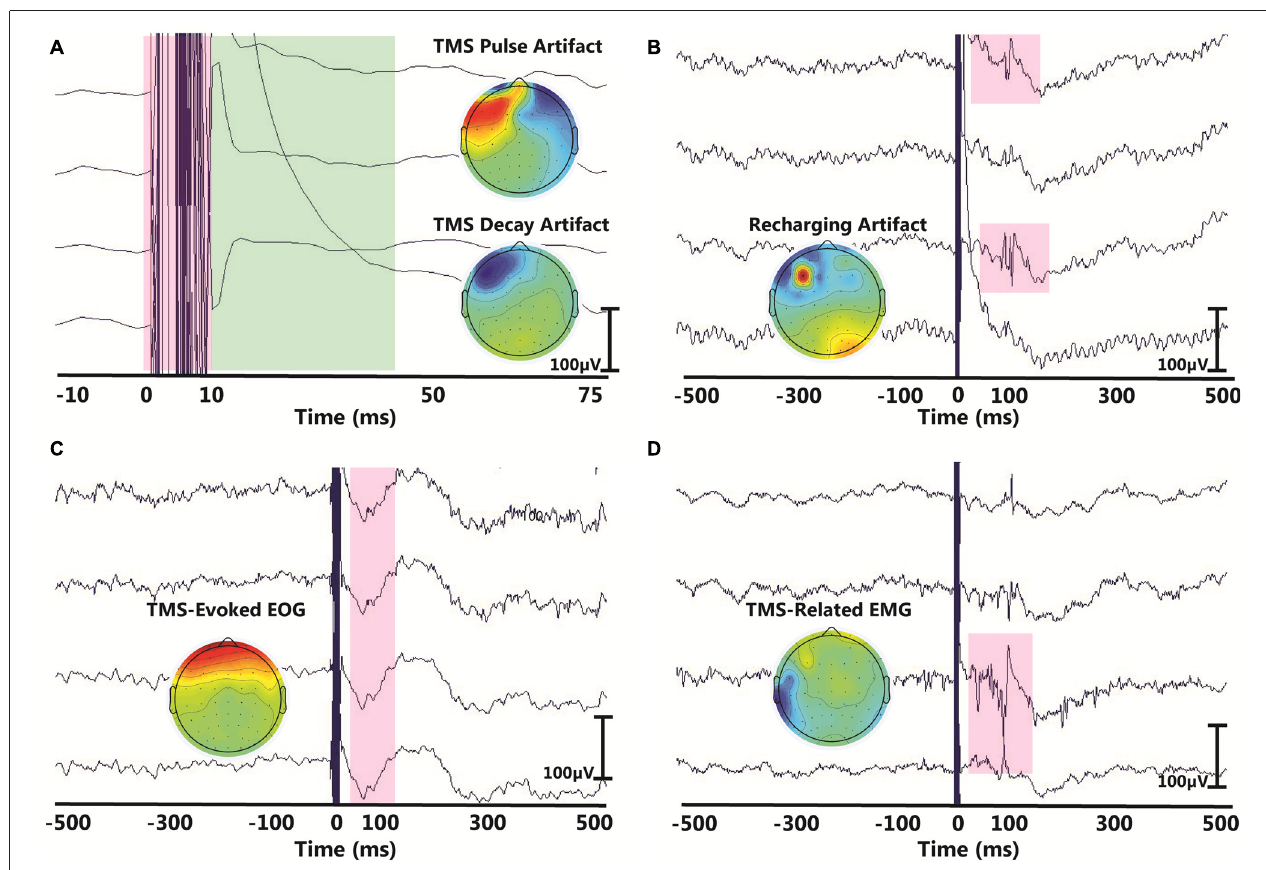
FIGURE 1 | Examples of common artifacts in transcranial magnetic stimulation-electroencephalography (TMS-EEG) data. In each panel, the x -axis represents time in the millisecond range and y -axis represents the amplitude of the EEG signal in the microvolt range. Topographical maps in each panel illustrate the scalp projection of each corresponding artifact. The displayed artifacts are: (A) the large-amplitude TMS pulse artifact (red) with the associated TMS decay artifact (green), (B) recharging artifact, (C) TMS-evoked eye blink artifact and (D) TMS-related muscle